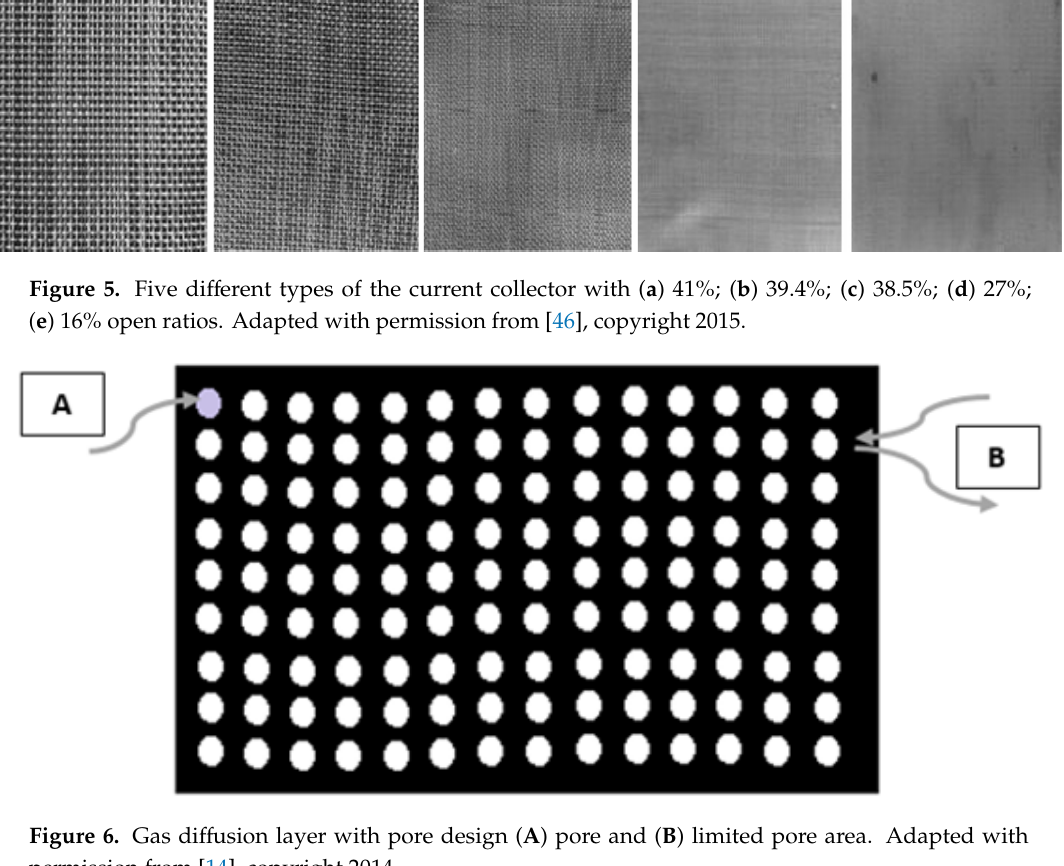
Figure 6. Gas di ff usion layer with pore design ( A ) pore and ( B ) limited pore area. Adapted with permission from [14], copyright 2014.